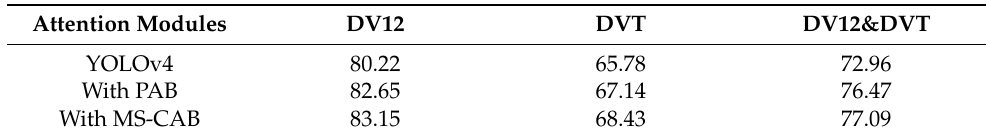
growth cycle data (AP, unit: %).